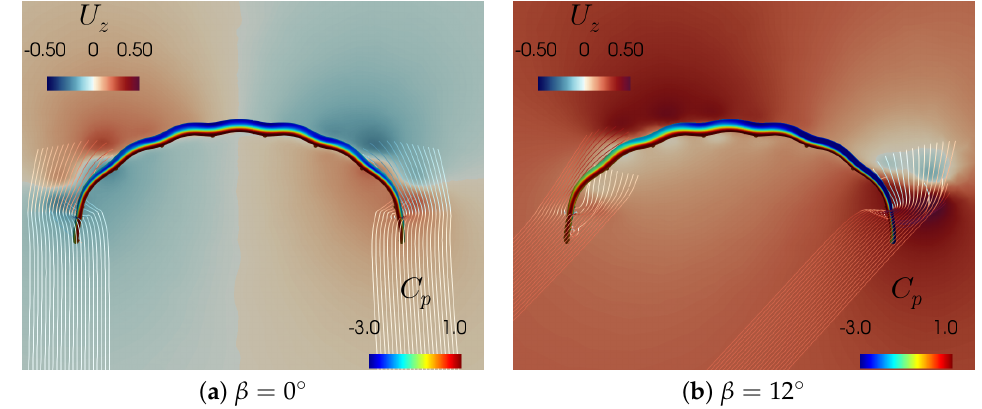
Figure 15. Pressure coefficient C P (colouring of wing surface) and transverse component U z of the flow velocity (colouring of an YZ -plane in the wake flow) for Re = 3 × 10 6 and α = 12 ◦ , taken from [23].